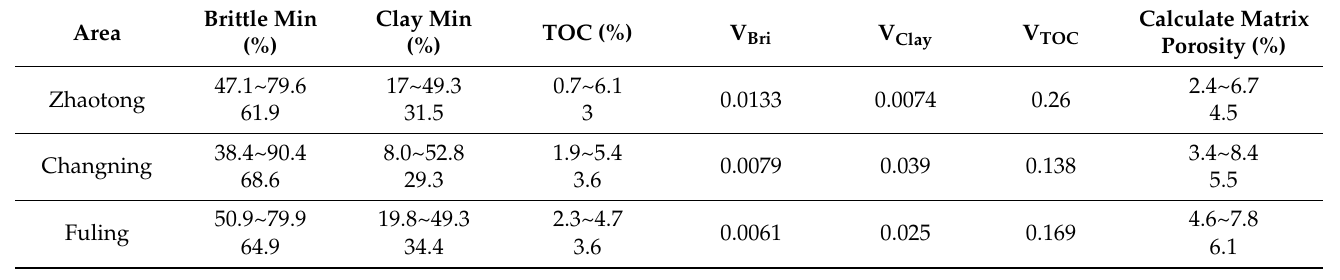
Table 3. Comparison of reservoir parameters between Wufeng–Longmaxi Formation shale in Zhao- tong Area and other areas.